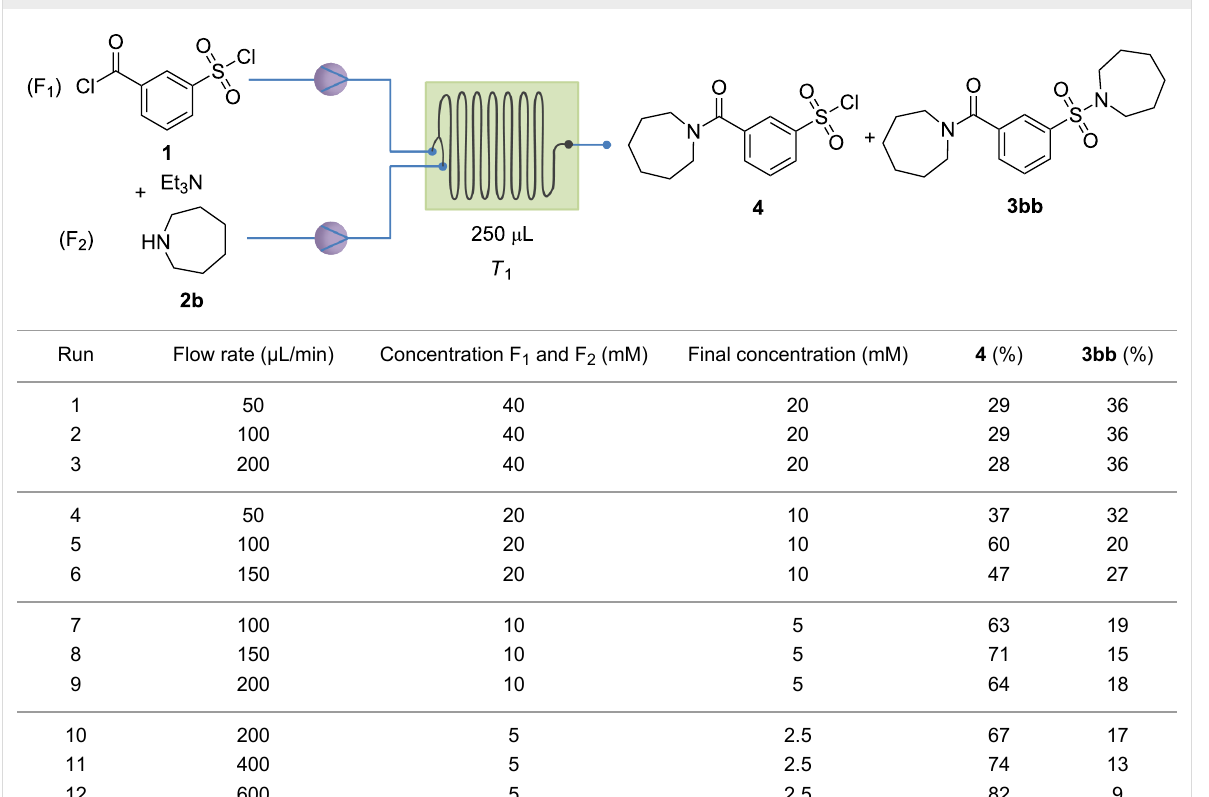
Run Flow rate (µL/min) Concentration F 1 and F 2